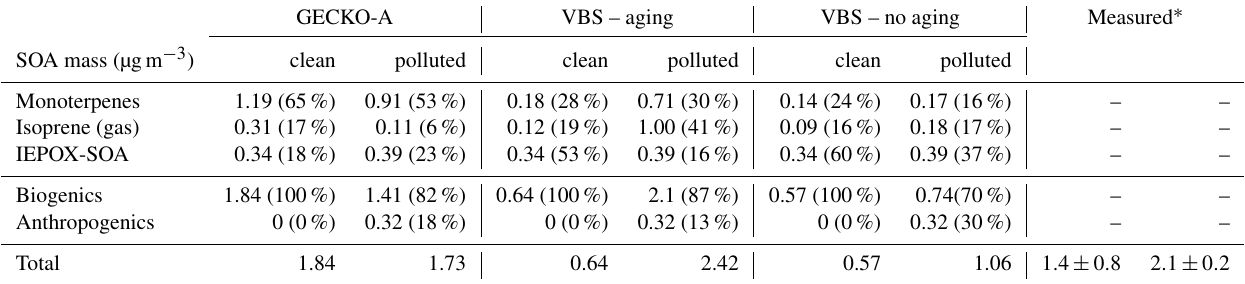
Table 2. Contribution of primary hydrocarbon categories to modeled SOA mass at 14:00LT. Percentages in parentheses indicate the relative contribution to total SOA mass.